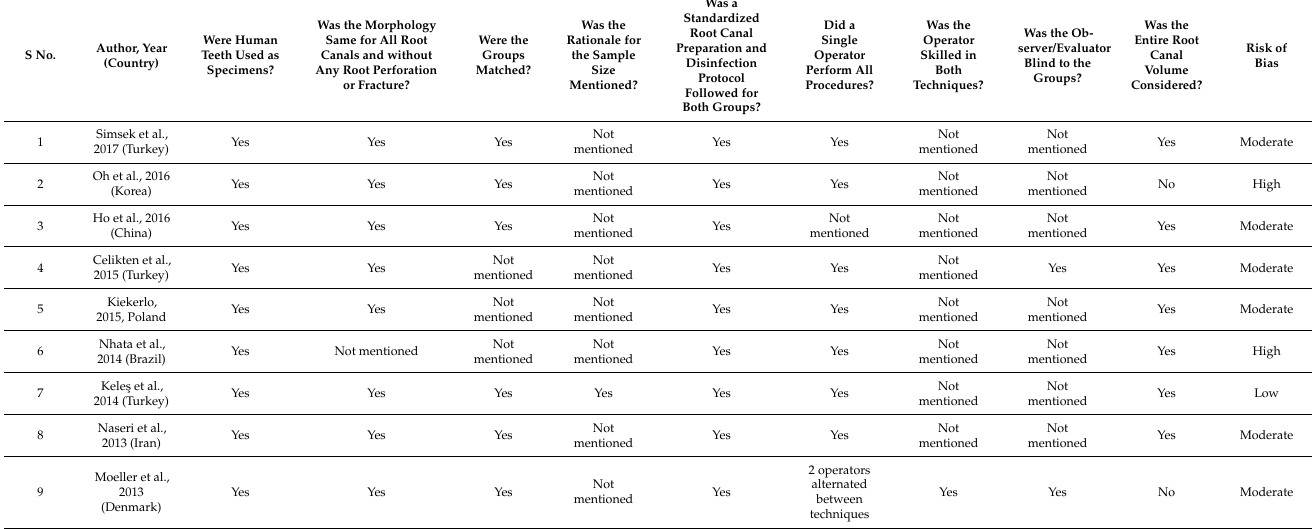
Table 3. Assessment of risk of